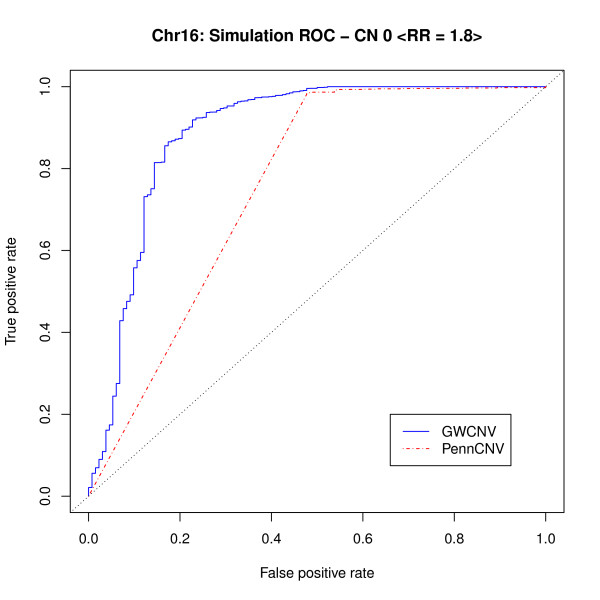
ROC curve for simulated weak signals (RR1 = 1.8).